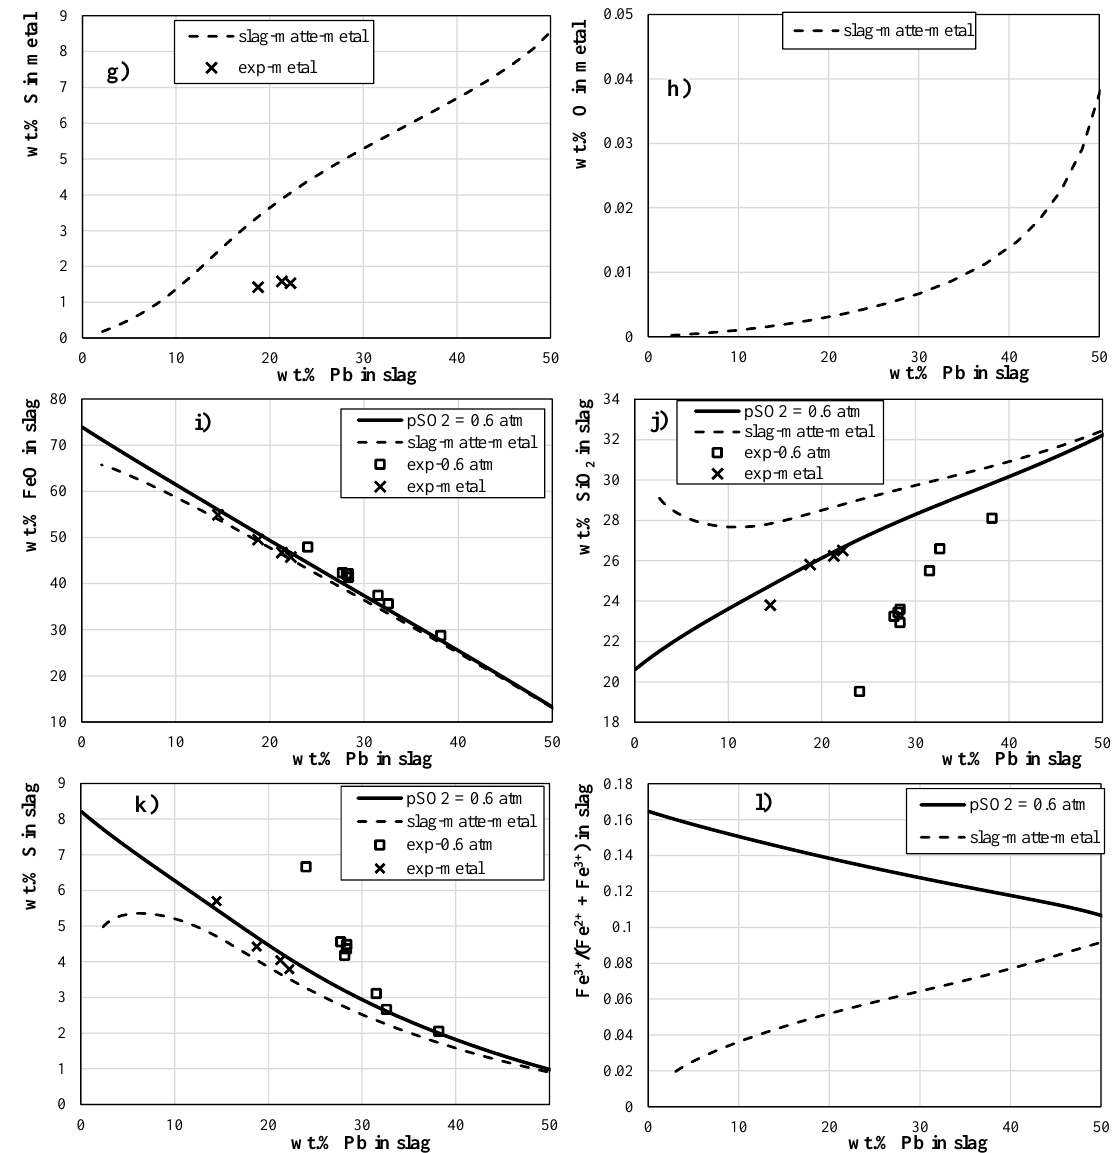
Figure 11. Set of graphs describing equilibria in the Pb-Fe-O-S-Si system at 1200 °C and 1 atm of total pressure between slag, matte, tridymite, and metal (dashed lines and squares), or between gas, slag, matte, and tridymite p (SO 2 ) = 0.6 atm (solid lines and crosses) at various equilibration times between 0.25 and 3 h, including ( a ) wt.% Pb in matte; ( b ) wt.% Fe in matte; ( c ) wt.% S in matte; ( d ) wt.% O in matte; ( e ) wt.% Pb in metal; ( f ) wt.% Fe in metal; ( g ) wt.% S in metal; ( h ) wt.% O in metal; ( i ) wt.% FeO in slag; ( j ) wt.% SiO 2 in slag; ( k ) wt.% S in slag; ( l ) fraction of Fe 3+ /total Fe in slag as functions of wt.% Pb in slag. The lines are calculated with the internal FactSage thermodynamic database [4,5]. The label “exp-metal” indicates the experiments in a closed slag–matte–metal